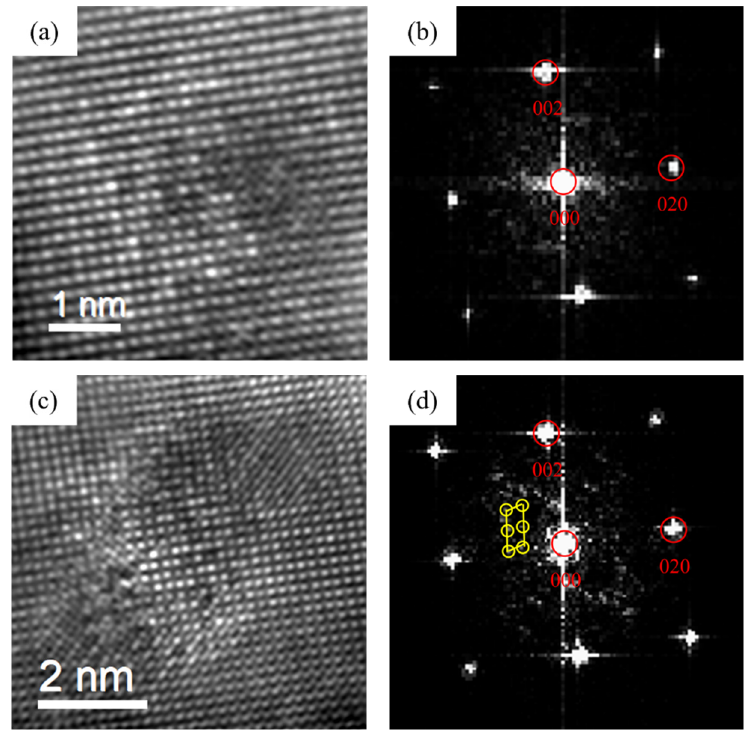
Figure 6. HRTEM and FFT pa tt erns of precipitates of 0.18Cu alloy after initial aging at 175 °C for 0.5 h. ( a , b ) GP zones; ( c , d ) pre- β″ .